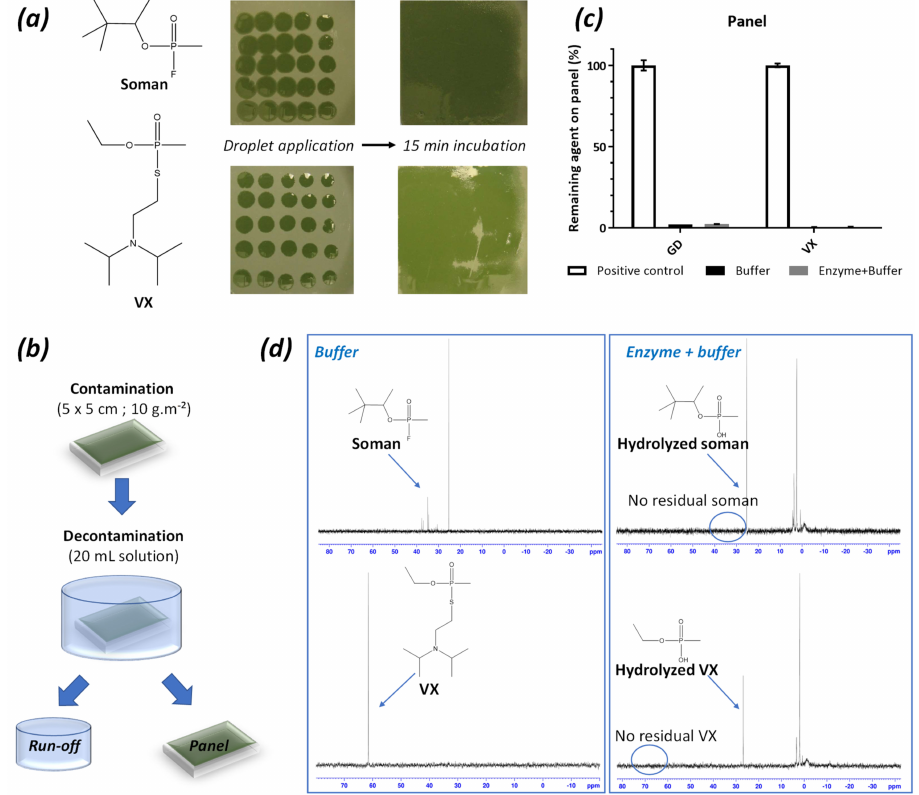
Figure 4. Enzyme decontamination of painted panels. ( a ) Contamination of panels with droplets of agent to reach a final contamination of 10 g · m − 2 of soman or VX. ( b ) Contaminated panels (5 × 5 cm) are incubated for 15 min in 20 mL of decontamination solutions. ( c ) Evaluation of residual soman (GD) and VX on panels after decontamination. ( d ) Evaluating remaining soman and VX in liquid decontamination (run-off)